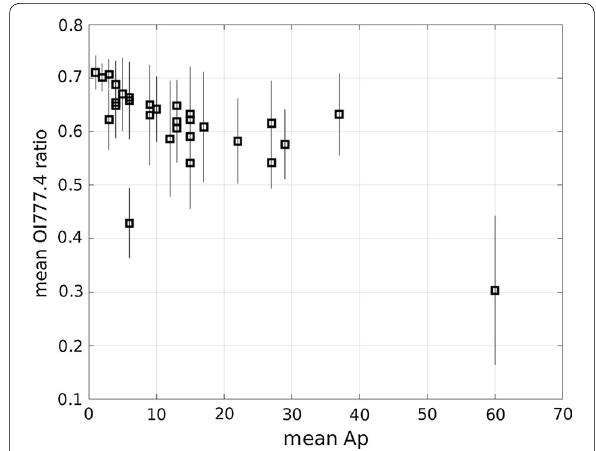
Fig. 4 Geomagnetic activity dependency of the mean OI (777.4) ratio, which is derived from all available data that were obtained from October 9, 2016 to April 15, 2017. The vertical bar is the statistical standard deviation ( 1 σ ±